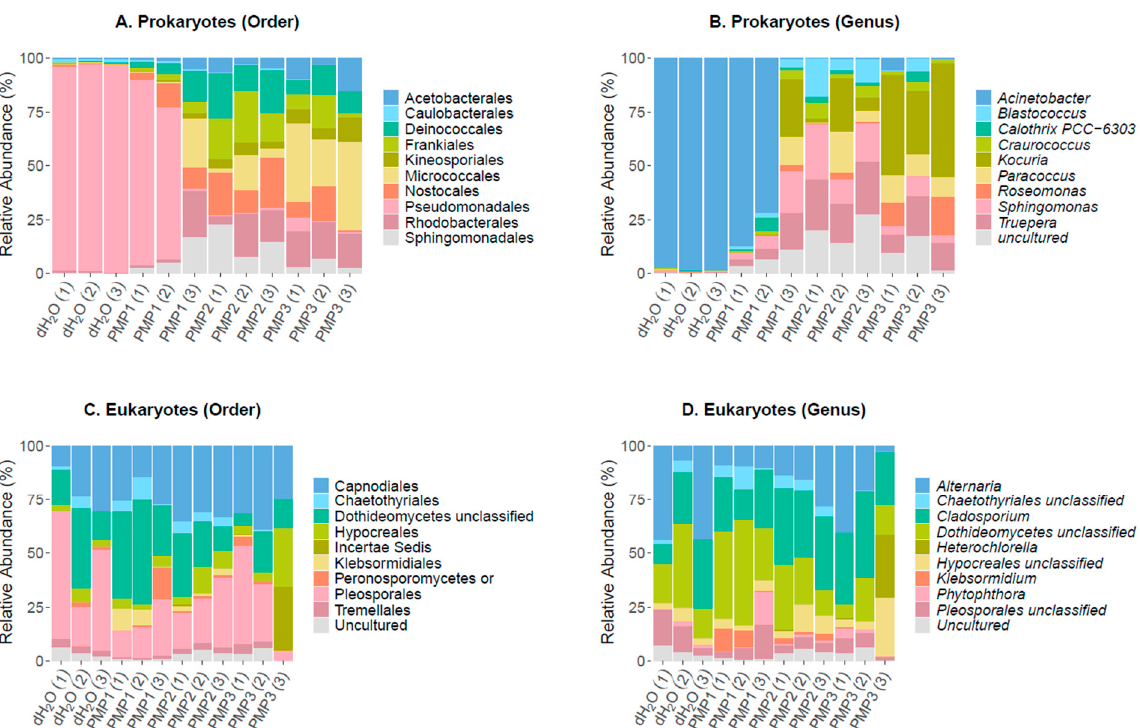
Figure 8. Profile of leaf epiphytic prokaryotic and eukaryotic microbial communities. Distribution of major prokaryotic ( A ) and eukaryotic ( C ) orders and genera ( B ) and ( D ), respectively. The scale in the y axis reflects the normalized relative abundance percentages (%).